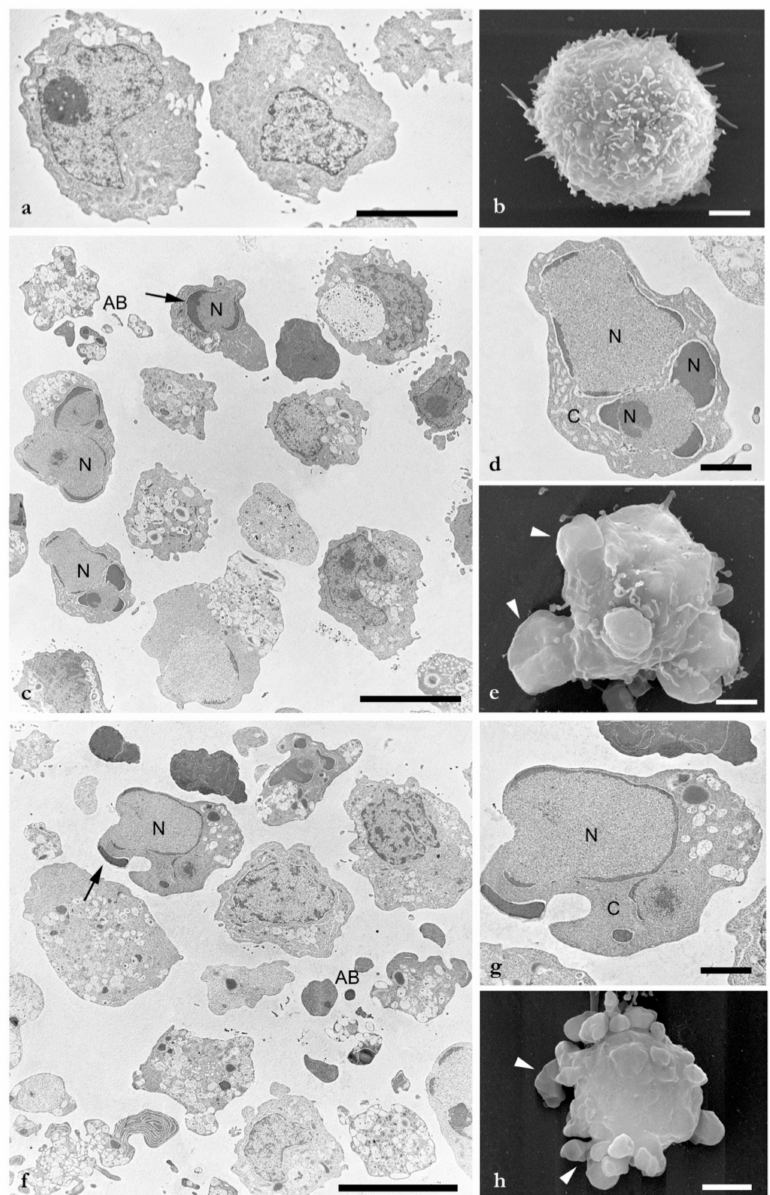
Figure 2. SEM and TEM investigations of HL60 cells were carried out to evaluate the apoptosis morphological changes induced by LEO treatments for 24 h; ( a ) TEM of DMSO treated HL60 cells, solvent control; ( b ) SEM of DMSO treated HL60 cells, solvent control; ( c ) TEM of HL60 treated with LEO; ( d ) higher TEM magnification of HL60 treated with LEO; ( e ) SEM of LEO treated HL60 cells; ( f ) TEM of puromycin treated HL60 cells; ( g ) higher TEM magnification of HL60 treated with puromycin; ( h ) SEM of puromycin-treated HL60 cells. Nuclei (N), cytoplasm (C), half-moon nuclei (arrows), membrane apoptotic bodies (AB), plasma membrane blebbing (arrows heads). Bars = a) 5 µ m; b, d, e, g, h) 2 µ m; c, f) 10 µ